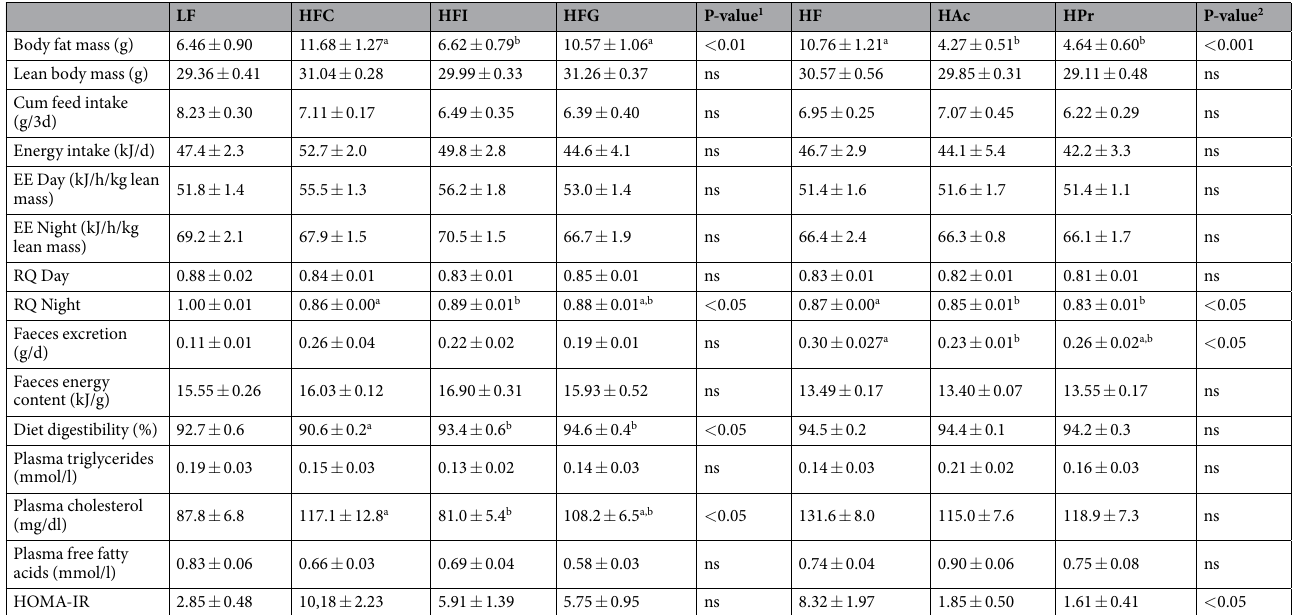
Table 1. Inulin and SCFA diminish fat mass gain, while only propionate reduces the RQ level during night. Table shows the summary of body composition (wk 30; n = 20–22), energy homeostasis (wk 10; n = 10–11) and plasma parameters (wk 30; n = 10), as well as HOMA-IR values (wk 20; n = 10–11) of male C57BL/6JRj mice fed a semi-synthetic low-fat diet (LF) or high-fat diets (HF) supplemented with either 10% dietary fibre (HFC: 10% cellulose; HFI: 3% cellulose + 7% inulin; HFG: 3% cellulose + 7% guar gum) or 5% SCFA with different Ac:Pr ratios, a high acetate (HAc; 10:1 Ac:Pr) or high propionate diet (HPr; 1:2.5 Ac:Pr) for 30 weeks. Data are mean + / − SEM. Statistical tests were performed among 1 dietary fibre groups (HFC, HFI, HFG) and 2 SCFA-groups (HF, HAc, HPr); Cum: cumulative; EE: energy expenditure; RQ: respiratory quotient; HOMA-IR: homeostatic model assessment value for insulin